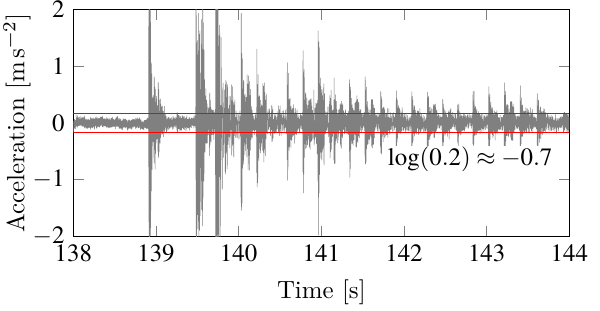
Figure 15. The acceleration pattern typically acquired during the tests, with the amplitude threshold that defined actual